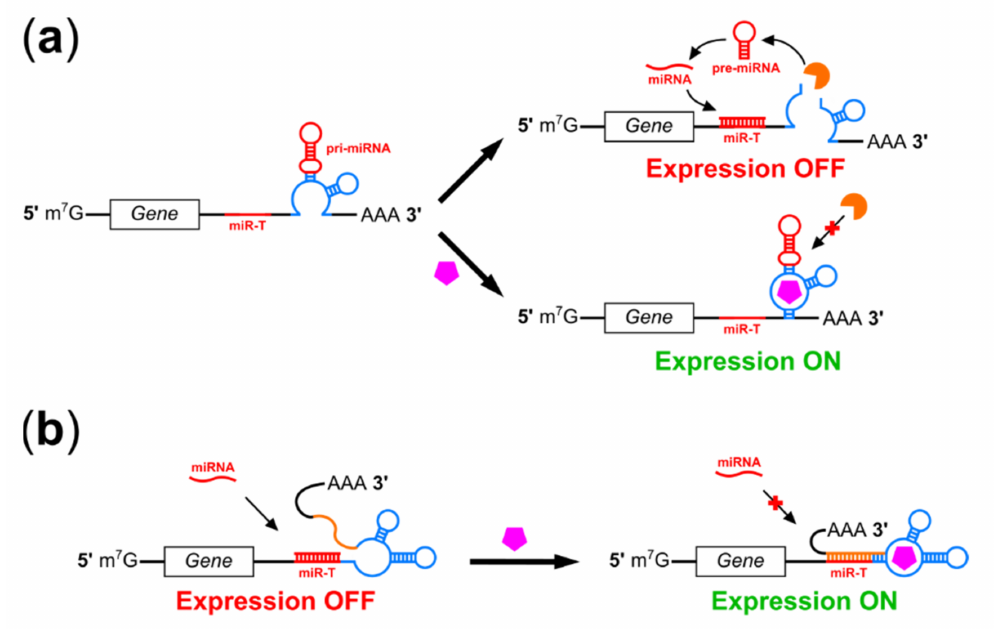
Figure 3. RNAi-Mediated Riboswitches in Mammalian Cells. ( a ) Regulation of miRNA processing. Pri-miRNA hairpins (red) can be conjugated to aptamers (blue) without disrupting processing, but ligand binding (magenta) occludes Drosha (orange). Insertion of these switches and an upstream miRNA target site (miR-T, red) into the 3 (cid:48) UTR of an mRNA results in mRNA degradation through cleavage by Drosha, as well as silencing by the resulting miRNAs. Ligand binding blocks Drosha pro- cessing, inhibiting both cleavage mechanisms and restoring gene expression [120,121]. ( b ) Regulation of miRNA target site accessibility. Insertion of a tetracycline aptamer (blue) and short compet- ing strand (orange) downstream of a miRNA target site (miR-T, red) allows tetracycline-mediated annealing of the competing strand to block RNAi and induce gene expression